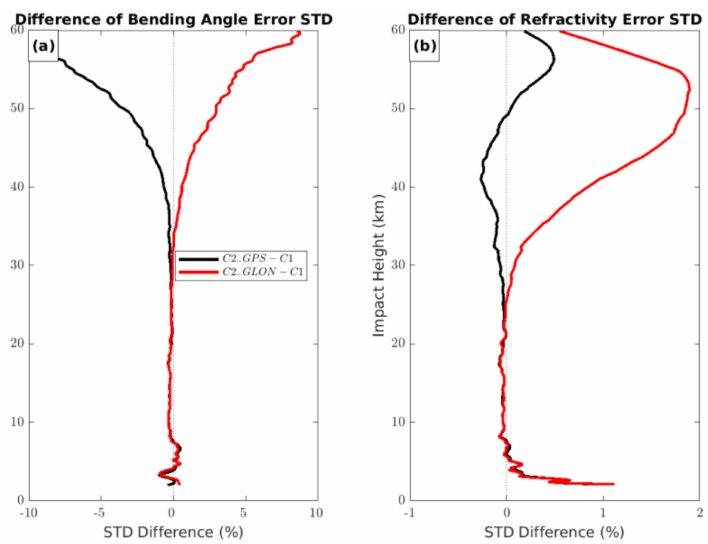
Figure 6. Differences of uncertainties (3CH error STD) of C2 (GPS, black) and C2 (GLONASS, red) and C1; bending angle ( a ) and refractivity ( b ). Negative values indicate C2 uncertainties are smaller than those of